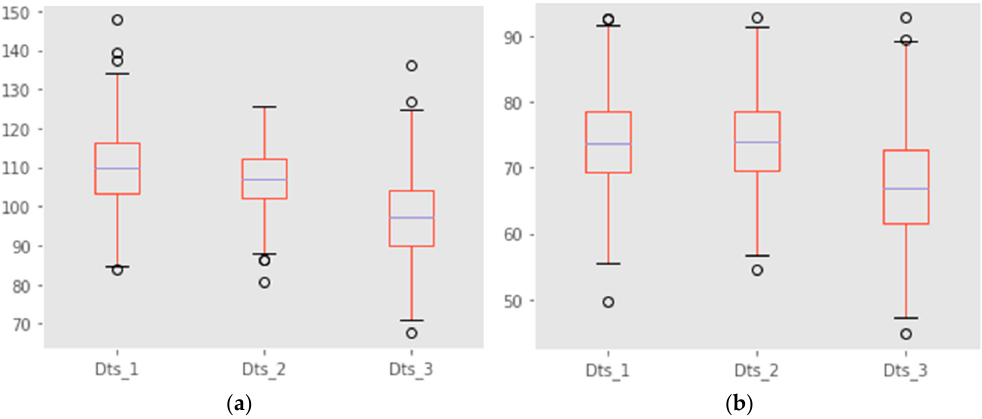
Figure 10. ( a ) Systolic box-plot representation and ( b ) diastolic box-plot representation.